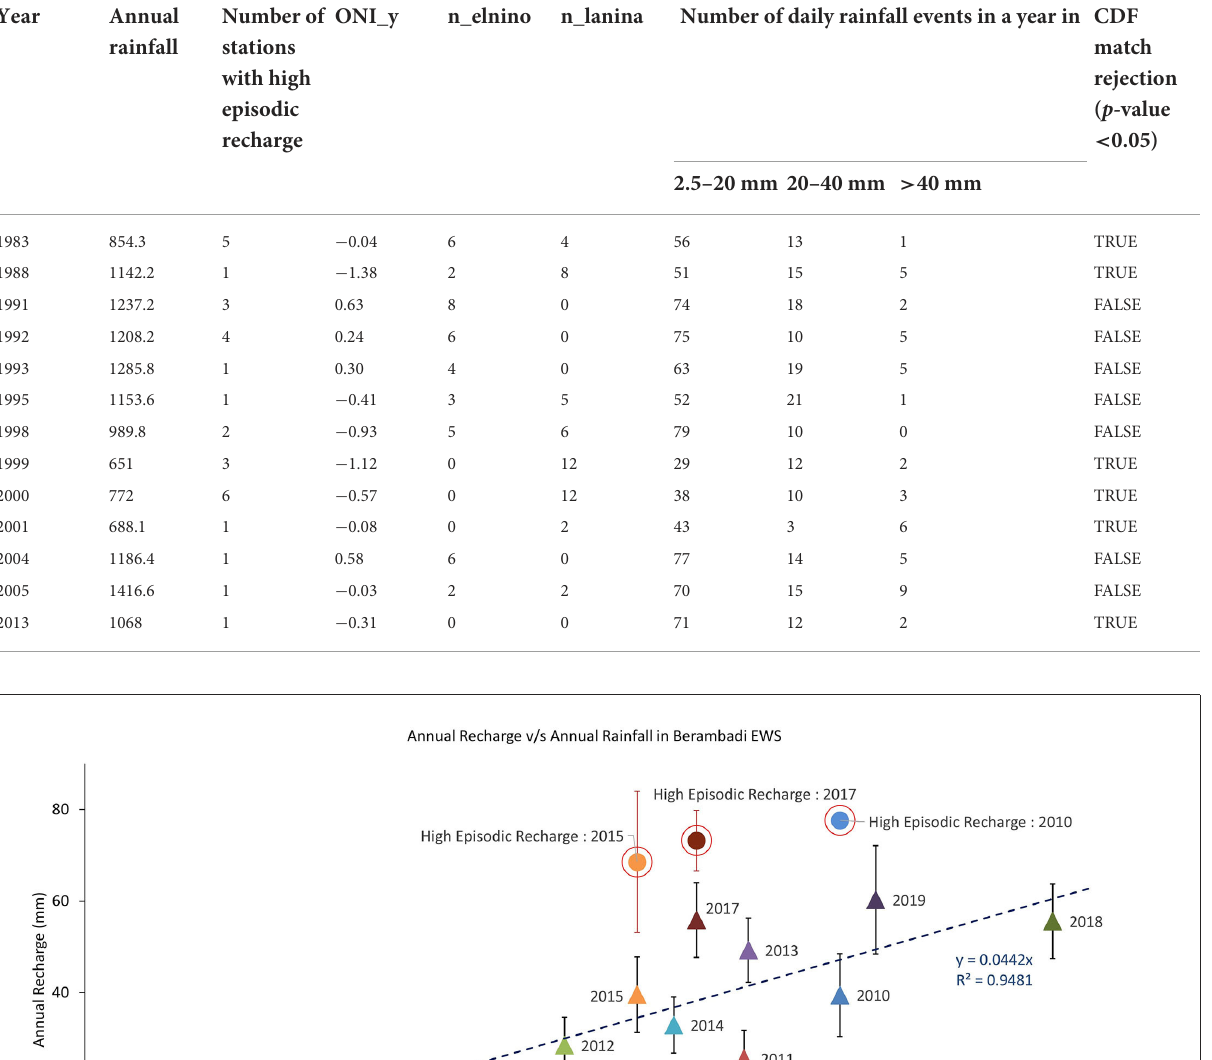
levels for the 10-year duration at B#133 in Berambadi EWS considering (Case-1) annual average recharge factor (4.4%) ignoring the high-episodic recharge events and (Case-2) model estimated varying recharge factor considering high-episodic